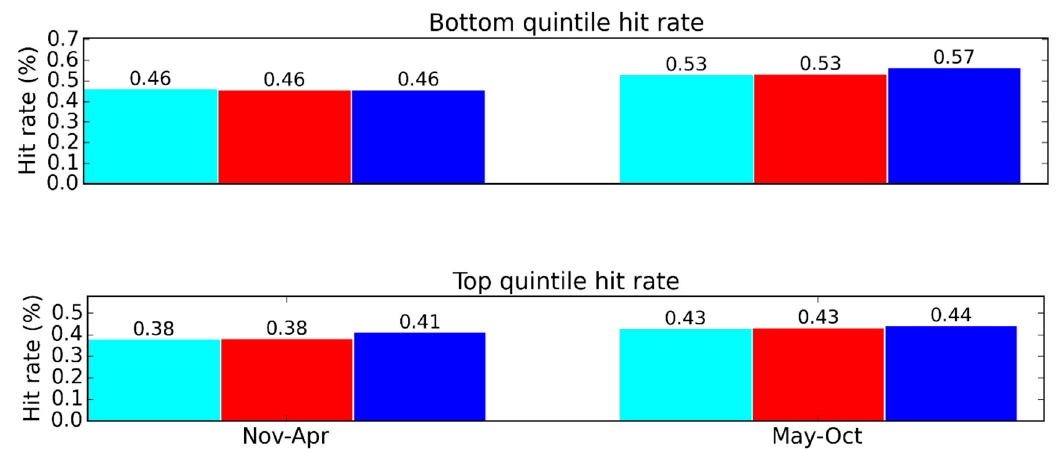
Figure 6. Seasonal gridded comparison from January 2001 to December 2018 for the wet season (Nov– Apr; left column) and dry season May–Oct; right column) using ERA5 as truth. Normalised mean average error (MAE) and the quintile hit rates are displayed.